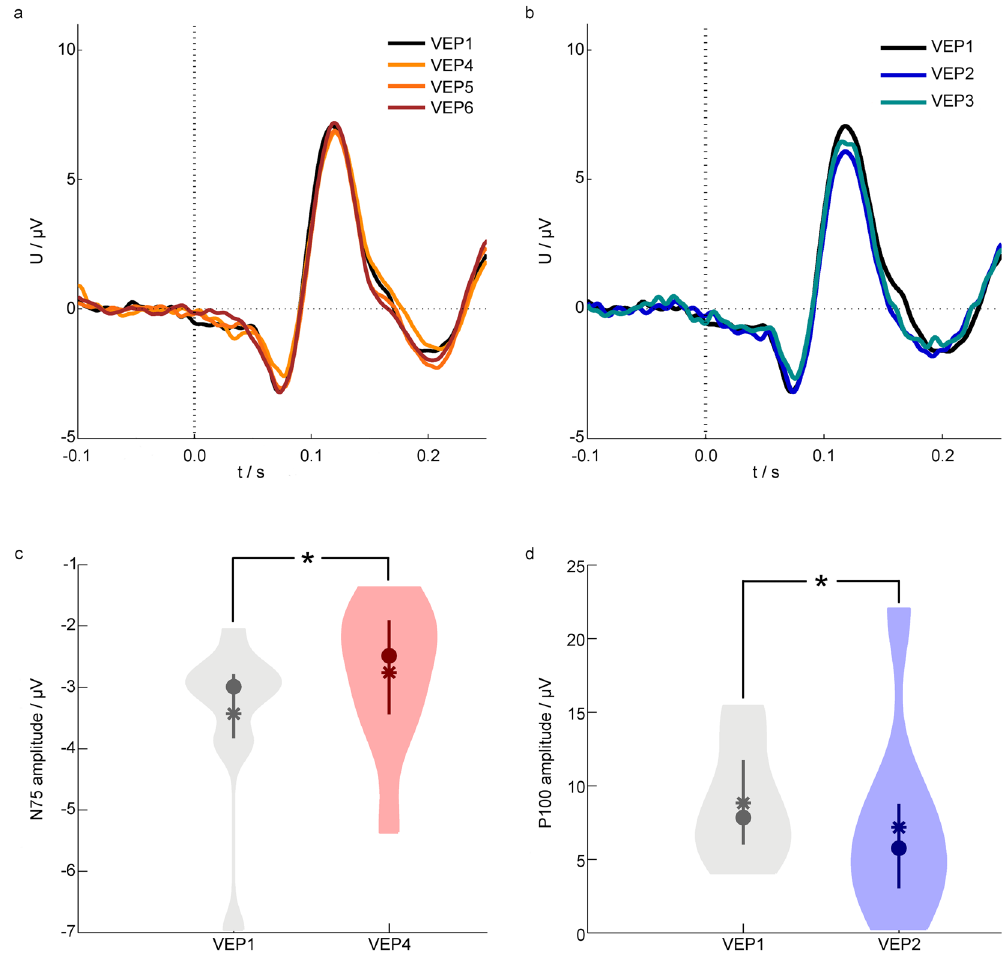
Figure 3. Grand average and statistical characteristics of the VEPs. ( a ) Grand average VEPs of all volunteers before and after tDCS in channel PO2. ( b ) Grand average VEPs of all volunteers before and during tDCS in channel PO2. ( c – d ) Violin plots of the amplitudes of the N75 ( c ) and P100 ( d ) components. Statistical characteristics are depicted by the mean (squares), median (circles), interquartile range (vertical lines) and the distribution of the data smoothed based on a normal kernel density estimation (coloured areas). Statistically significant differences are indicated by * . | tDCS – transcranial direct current stimulation; VEP – visual evoked